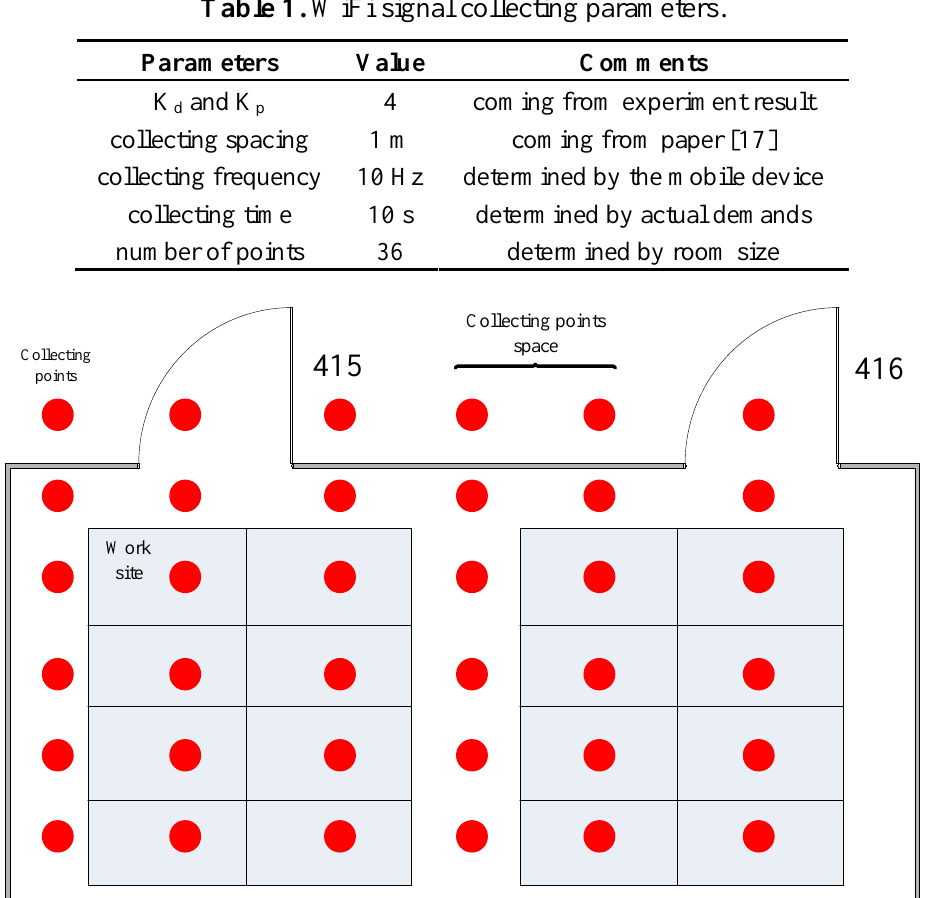
Table 1. WiFi signal collecting parameters.